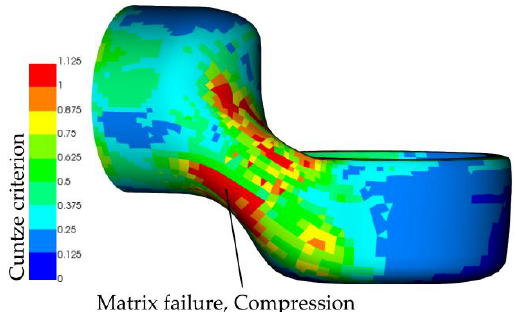
15 of 20 Figure 17. Direct validation of the as-built simulation models by comparison with the as-planned data. The composite model was set up according to [47] where two individual unidirec- tional plies are used to model every single fabric-reinforced layer. The fiber orientations, derived from evaluating the image data of the surfaces, are mapped in a unidirectional manner on the UD plies with half the original plies thickness. For the failure investigation, the Cuntze and the Puck Criterium [48,49] was used to evaluate the local composite fail-